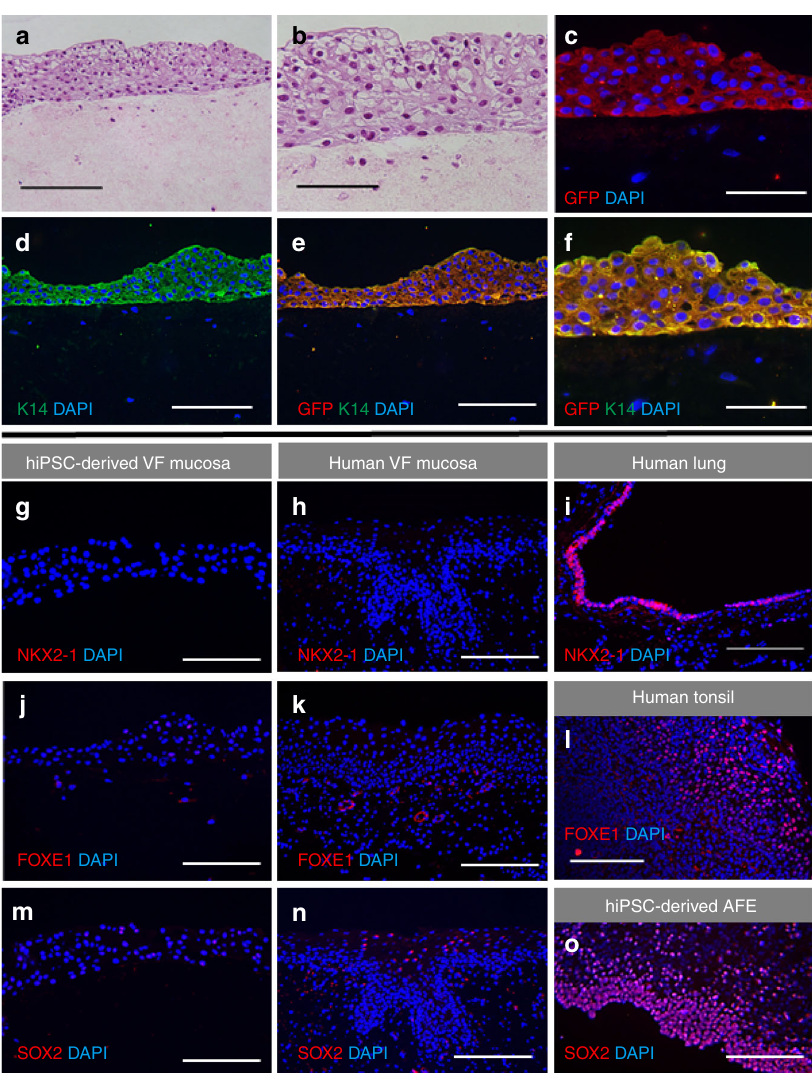
Fig. 5 Characterization of hiPSC-derived 3D VF mucosa. a , b Hematoxylin – eosin staining showing morphology of human iPSc-derived VFEC. c Immuno fl uorescent anti-GFP staining of VFEC showing persistency in GFP expression (red). d Immuno fl uorescence staining for Cytokeratin 14 (green). e , f Double staining of anti-GFP (red) and Cytokeratin 14 (green) showing that GFP + cells preferentially differentiate into Cytokeratin 14 + cells. Scale bars in the panels of a , d , and e = 200 μ m. Scale bars in the panels of b , c , and f = 100 μ m. g – o Con fi rmation of the speci fi city of VF epithelial differentiation examining NKX2-1 in red ( g , h ), FOXE1 in red ( j , k ), and SOX2 in red ( m , n ). HiPSC-derived VF epithelium and human VF mucosa were negative for NKX2-1, FOXE1, and SOX2. Human lungs were used as a positive control for NKX2-1 ( i ), human tonsils were used as a positive control for FOXE1 ( l ), and AFE cell cultures were used for con fi rmation of SOX2 expression ( o ). Scale bars in the panels of g – o = 200 μ m. AFE anterior foregut endoderm, hiPSC human induced pluripotent stem cell, VF vocal